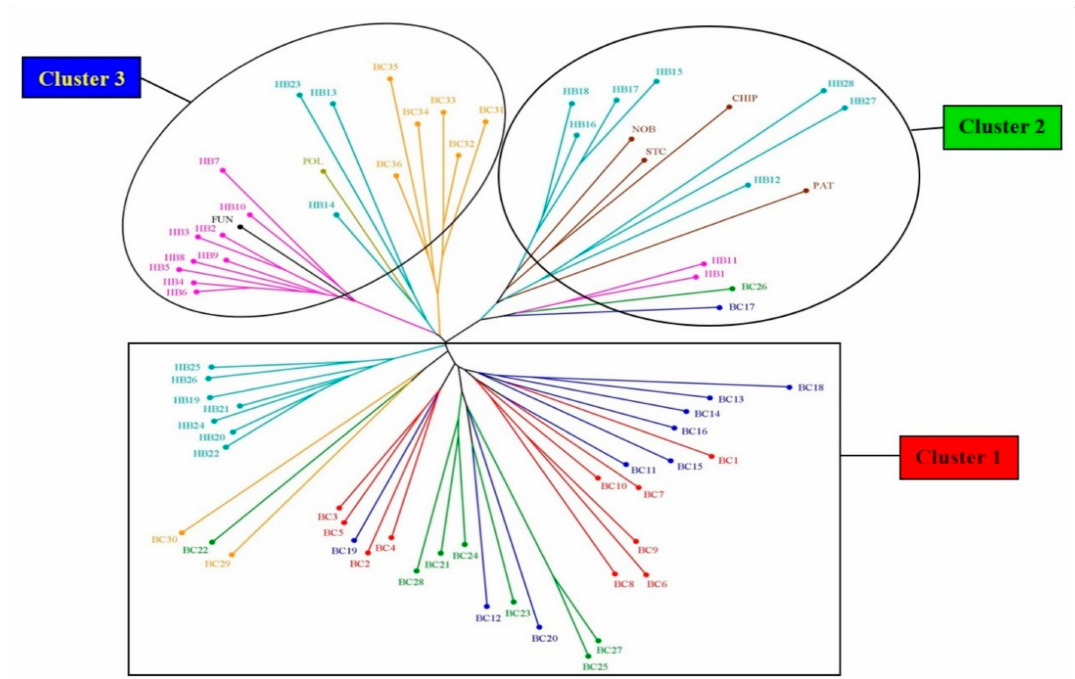
Figure 5. Dendrogram produced using the unweighted neighbour-joining (NJ) method based on genetic dissimilarity produced by the combination of EST–SSR, genomic (G)–SSR, and EST–PCR markers among blueberry genotypes. The colour of the branches indicates different groups (see Tables 1 and 2 for genotype